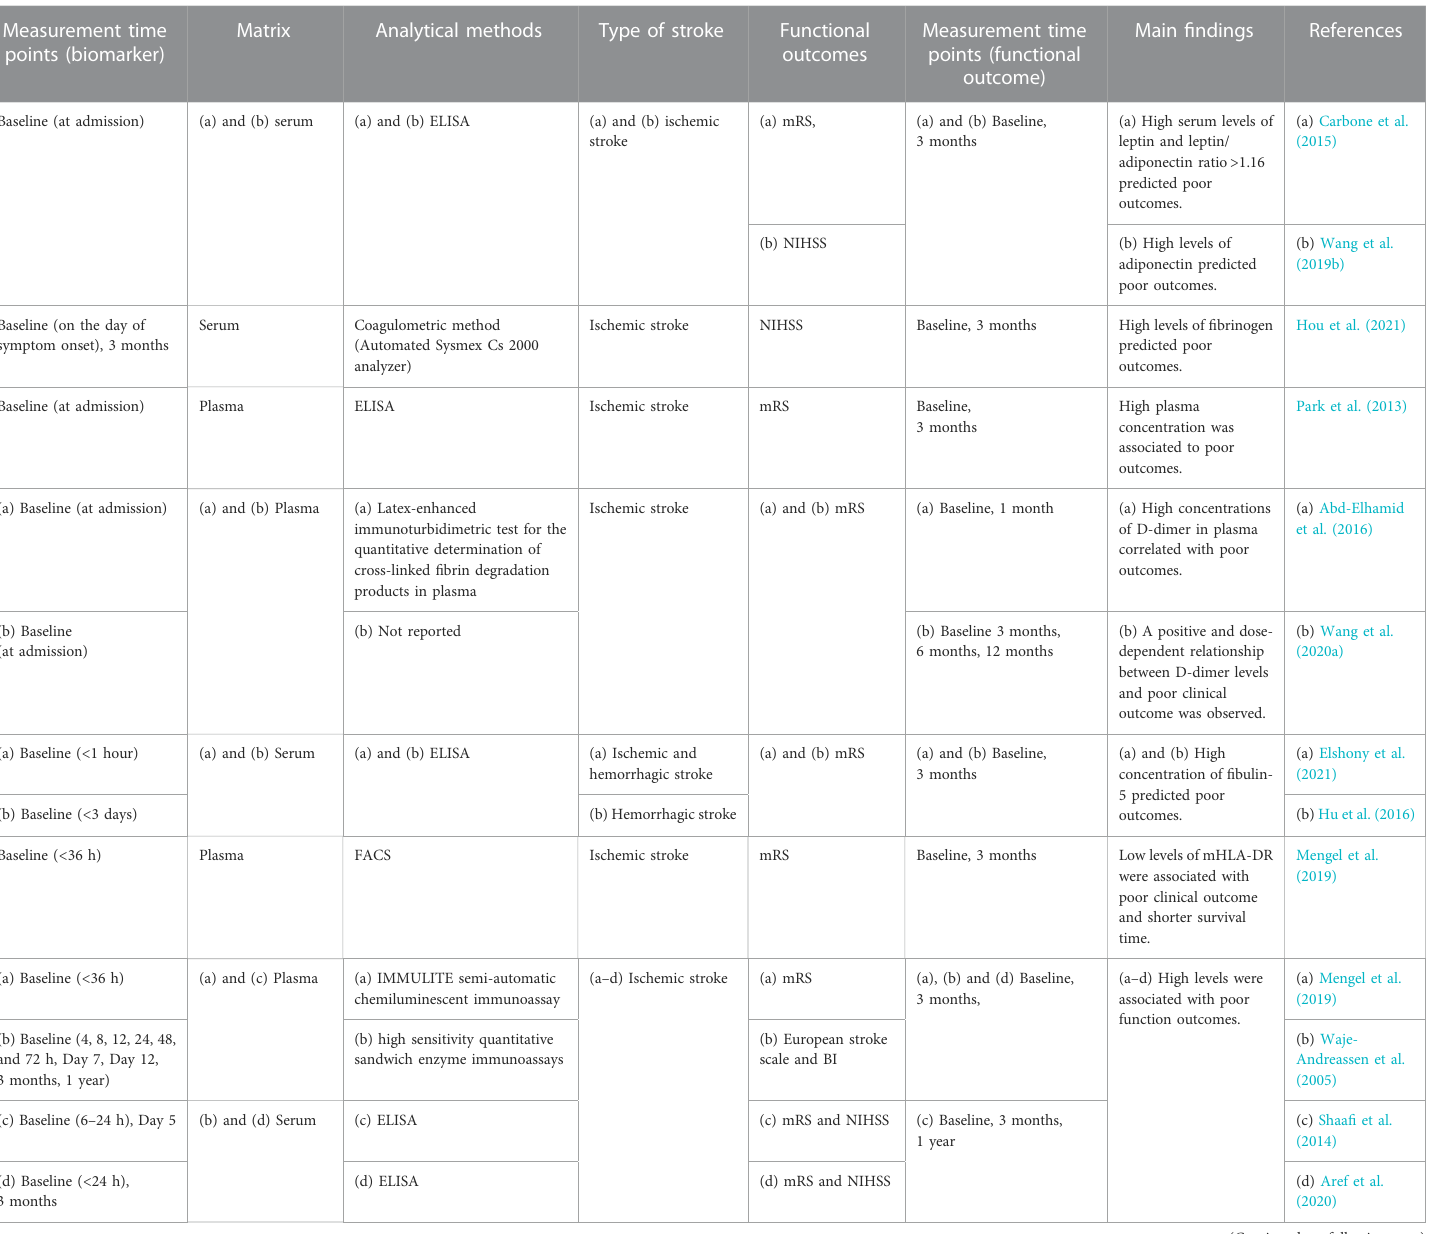
TABLE 2 ( Continued ) Molecular, genetic and epigenetic biomarkers for stroke